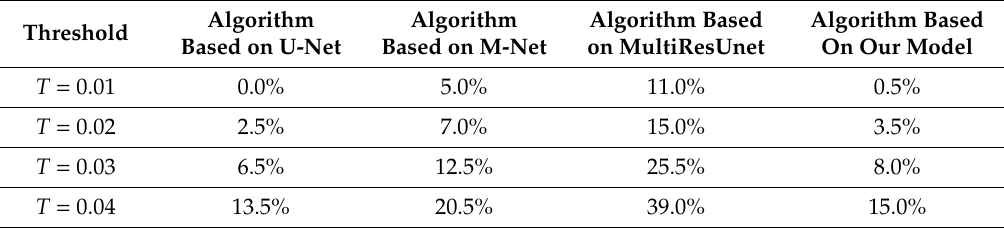
Figure 13. Example of subject related tampering: ( a ) Original HRRS images, ( b ) changing object, ( c ) removing object, ( d ) appending object. Table 9. Omission factor of sensitivity to tampering with removing